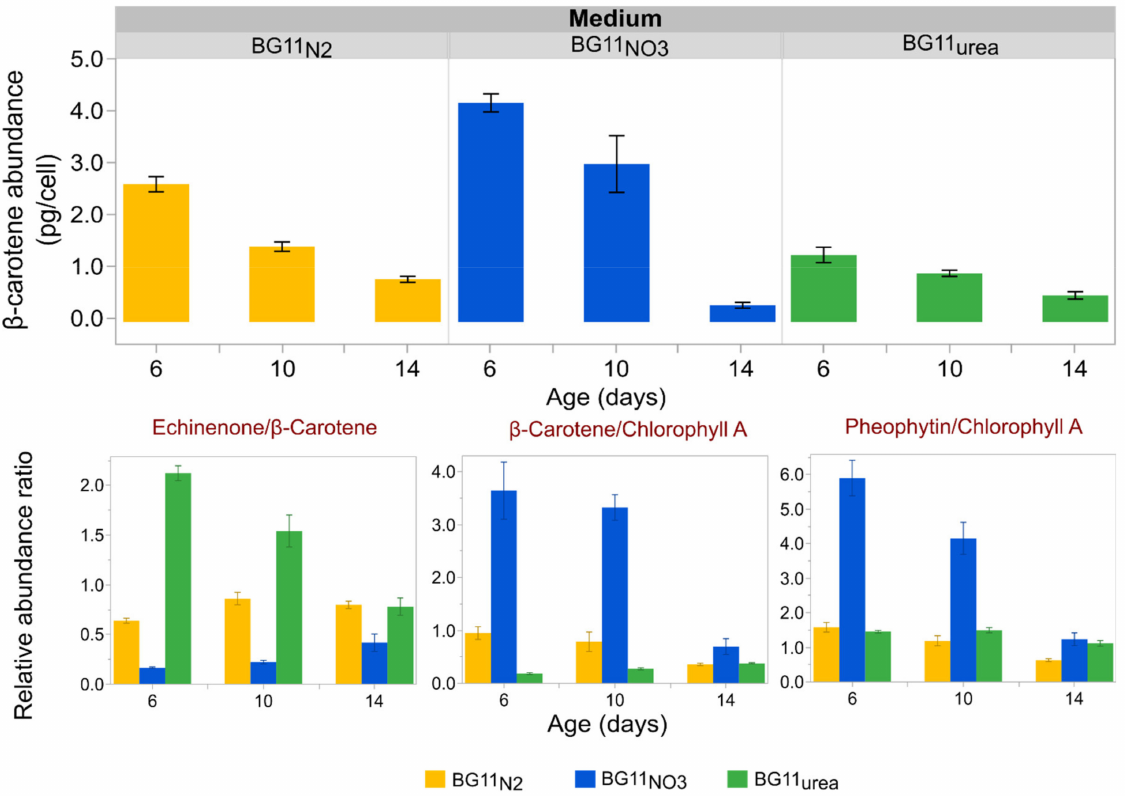
Figure 4. Cellular abundance and oxidation of β -carotene. Cellular abundance of β -carotene is reduced over time for BG11 N2 and BG11 NO3 cultures and is lowest for cells grown in BG11 urea medium (except for day 14). The echinenone to β -carotene ratio is used as an indicator of β -carotene oxidation, suggesting that cultures in BG11 urea are exposed to higher carotene-oxidation levels. The β -carotene to Chl a ratio indicates the abundance of non-oxidized carotenoid relative to the abundance of the main photosynthetic pigment. The pheophytin a to Chl a ratio is used as an indicator of photosystem II (PSII) integrity. Bars represent the mean of three measurements per sample and each error bar is constructed using one standard error from the mean. Data represent results for six biological replicates per medium